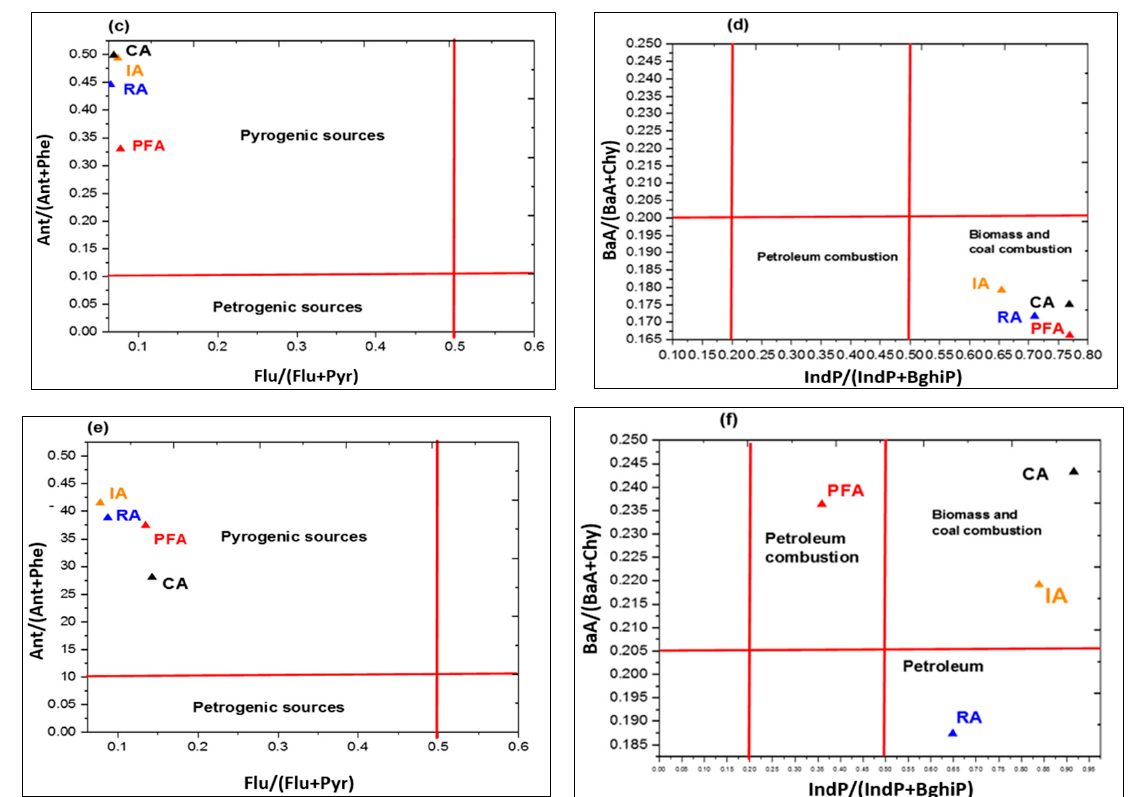
Figure 7. Scatterplot of isomer ratios of Ant/(Ant + Phe) versus Flu/(Flu + Pyr), and BaA/(BaA + Chy) versus IndP/(IndP + BghiP) for PAHs sources before lockdown ( a , b ); during partial lockdown ( c , d ); and during complete lockdown ( e , f ).